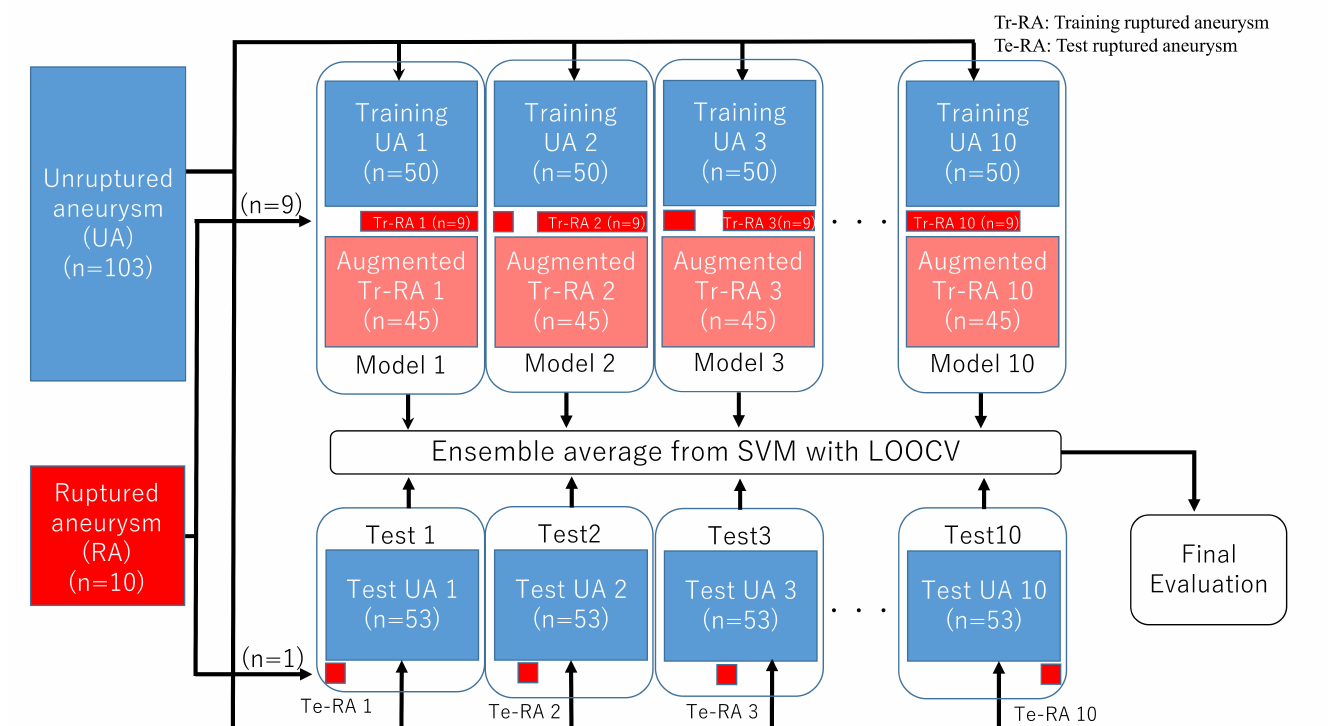
Figure 2. Building and evaluation of a rupture prediction model based on imbalance adjustment